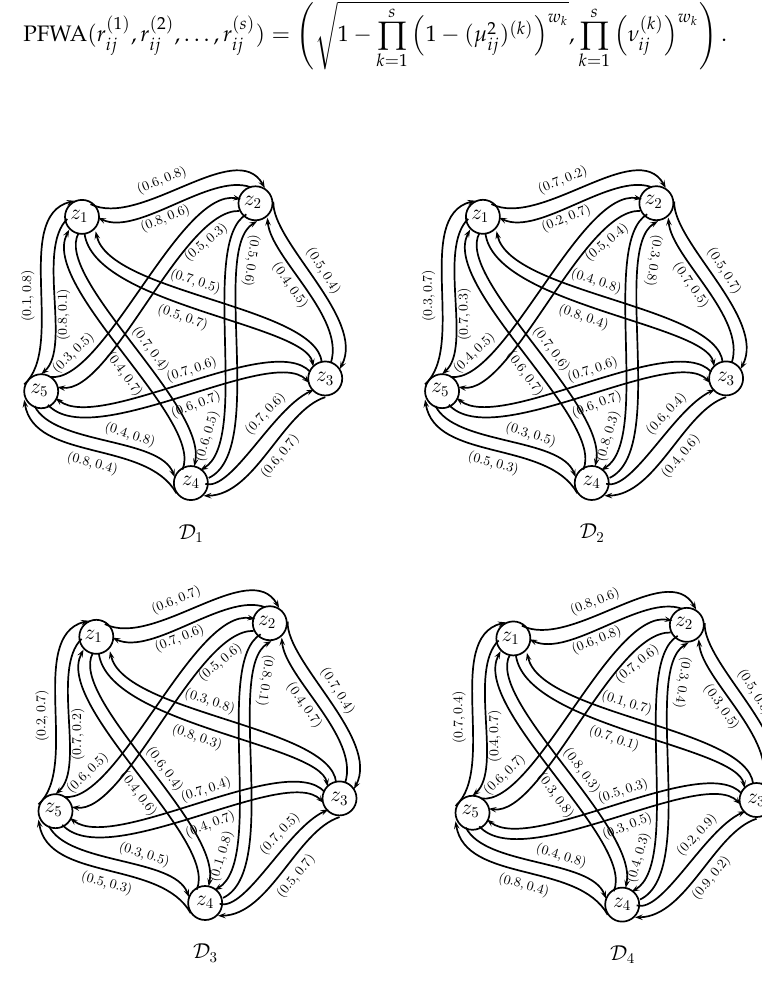
Figure 7. Pythagorean fuzzy